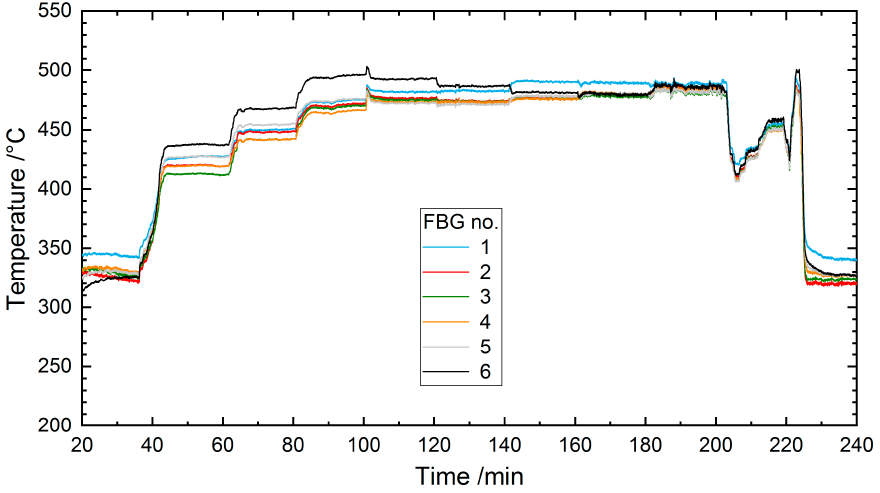
Figure 4. Time series of the temperatures measured with the six-point RFBG sensor array.